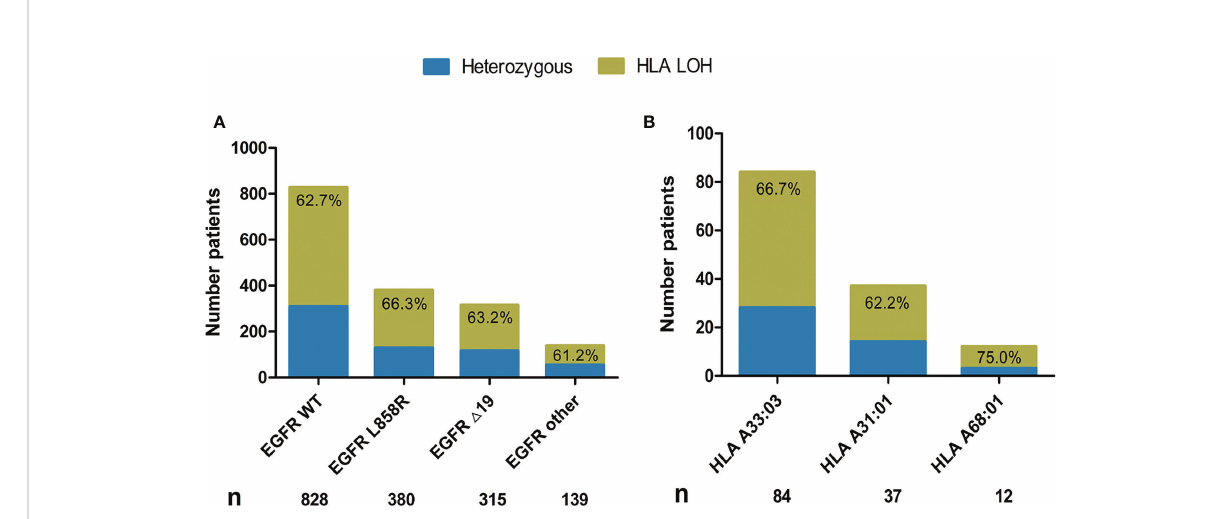
FIGURE 6 Frequency of HLA LOH in NSCLC. (A) The HLA LOH rate in the EGFR WT (n=828), EGFR L858R (n=380), EGFR 19del (n=315), and EGFR other (n=139). (B) The HLA LOH rate in HLA A*33:03 (n=84), HLA A*31:01 (n=37), and HLA A*68:01